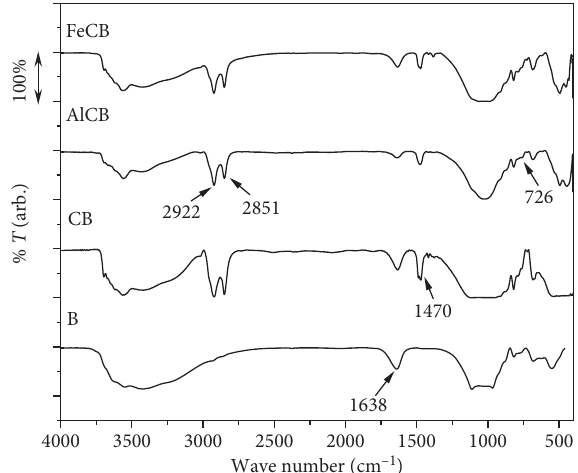
Figure 3: FT-IR spectra of B, CB, AlCB, and